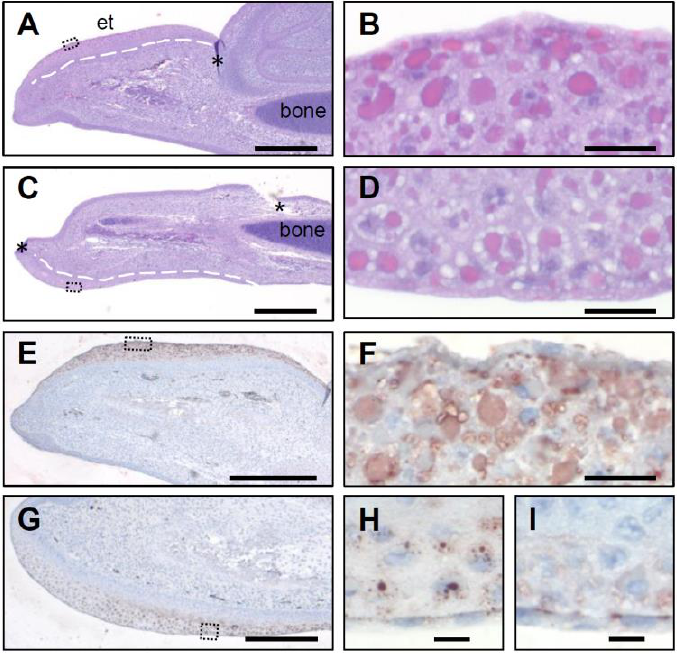
Figure 6. SCFN protein is expressed in the peridermal compartment of the quail egg tooth. Tissues were collected from quails at embryonic development stage E10. Hematoxylin and eosin stains of the upper ( A , B ) and lower beak ( C , D ) are shown. To localize SCFN protein in the quail beak, an immunohistochemical staining of SCFN was performed in the upper ( E , F ) and the lower quail beak ( G , H ). As control for the specificity of the result, anti-SCFN serum was blocked with the immunogenic peptide ( I ). Boxes in A , C , E and G indicate the region shown at higher magnification in B , D , F and H , respectively. Asterisks in A and C mark artefacts caused by the sectioning. Broken lines in A and C indicate border of periderm. et, egg tooth. Bars: 400 µm ( A , C , E ); 200 µm ( G ); 20 µm ( B , D , F ); 10 µm ( H , I ).